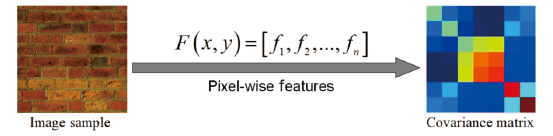
Fig. 2 Conceptual illustration of generating CovDs from images. F ( x,y ) is the feature vector at position ( x,y ) in the image sample, and is composed of information from different features such as intensity, gradient, Gabor wavelets,